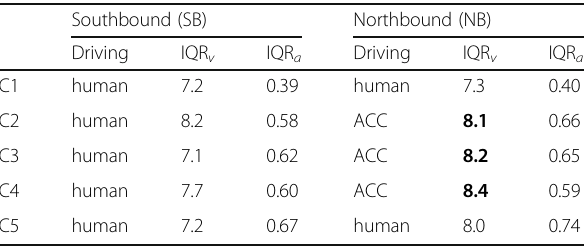
Table 2 Interquartile range (IQR) of speed ( v ) and acceleration ( a )